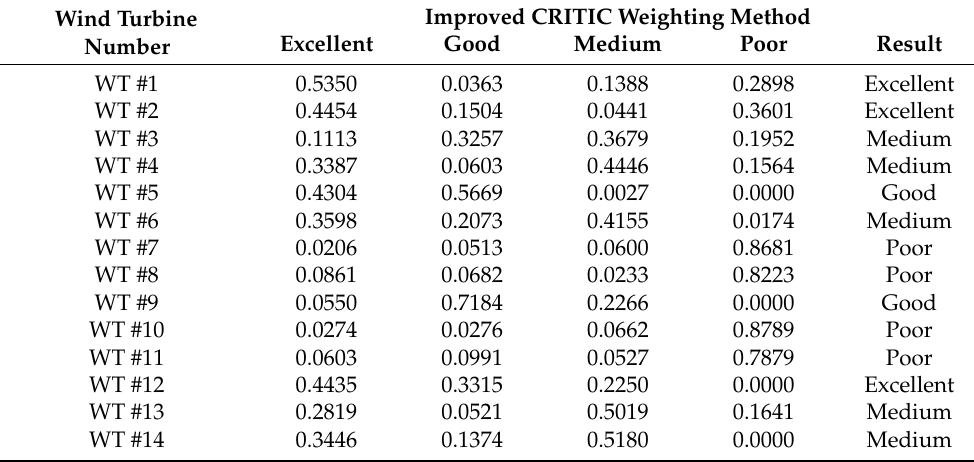
Table 6. The comprehensive evaluation results of wind turbines power generation performance (improved CRITIC weighting